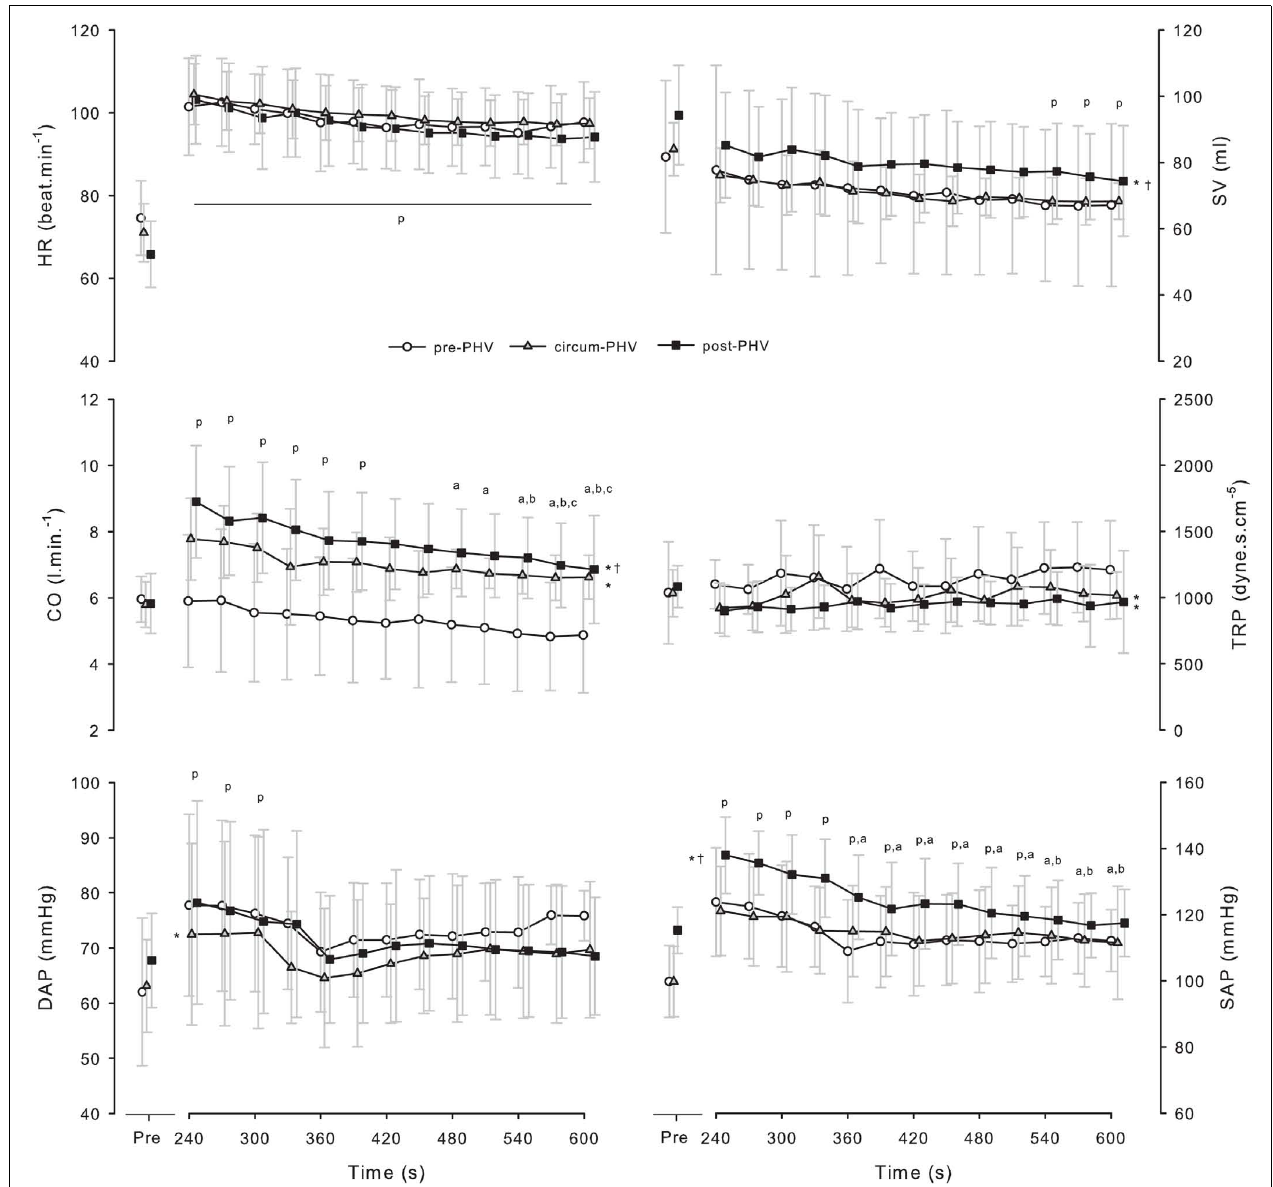
players. *, Significant difference vs. pre-PHV ( P < 0.05); † , significant difference vs. circum-PHV ( P < 0.05); p, significant difference vs. Pre ( P < 0.05); a, significant difference vs. post 240 ( P < 0.05); b, significant difference vs. Post 270 ( P < 0.05); c, significant difference vs. Post 300 ( P <